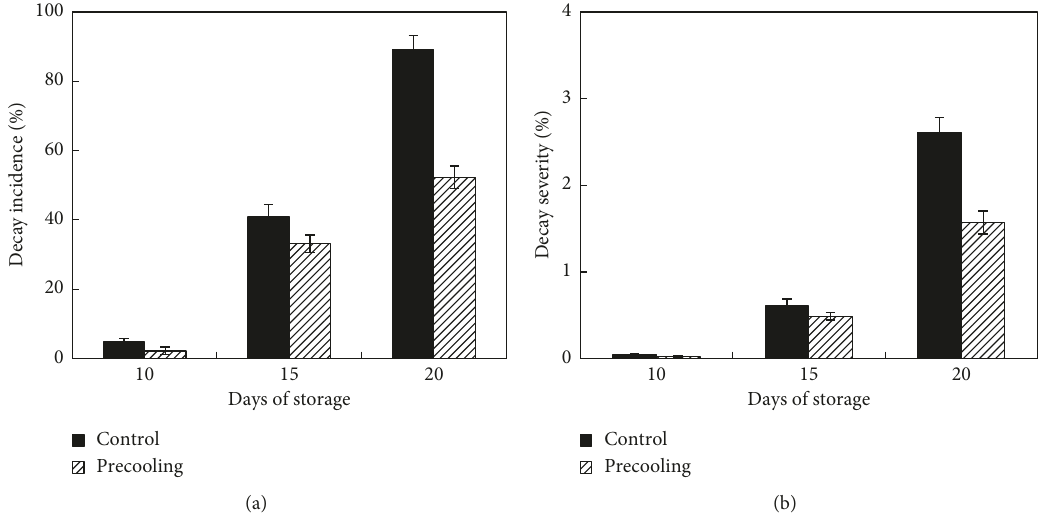
Figure 6: Effects of forced air precooling treatment on decay incidence (a) and decay severity